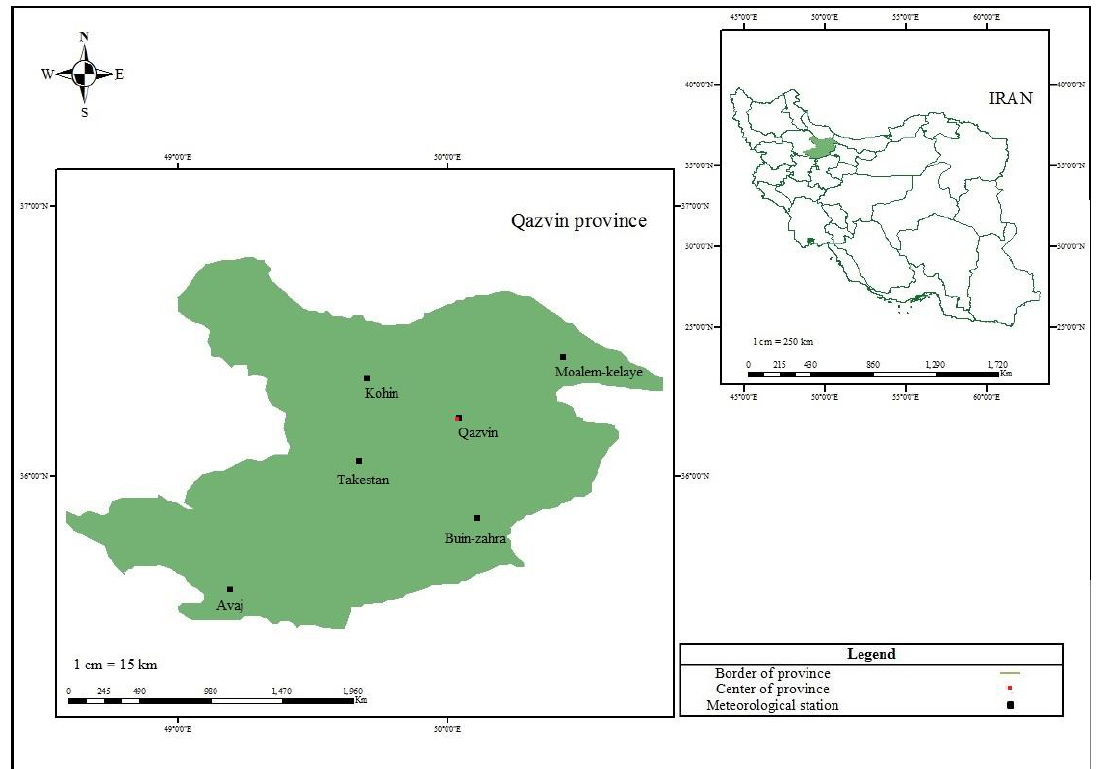
Figure 1. Map of the studied area.